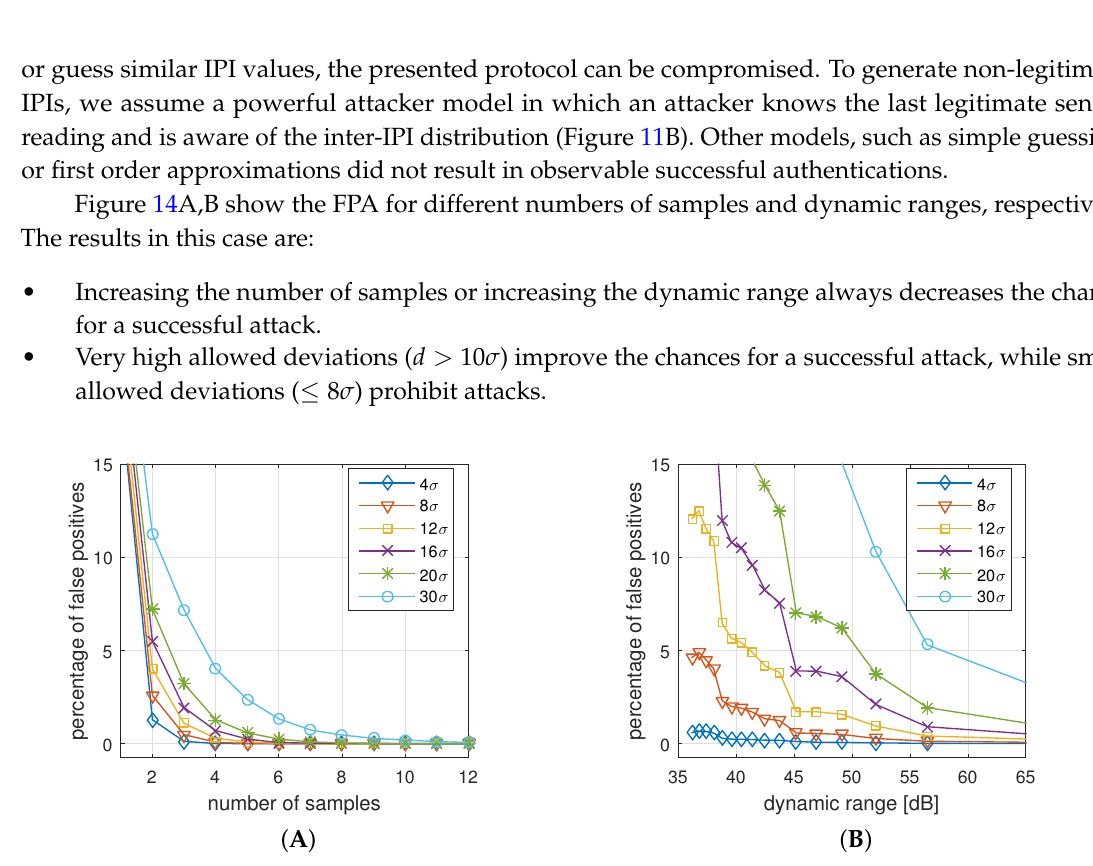
Figure 14. Accepted authentications (false positives) for forged authentication attempts, ( A ) for different number of samples; and ( B ) for different dynamic